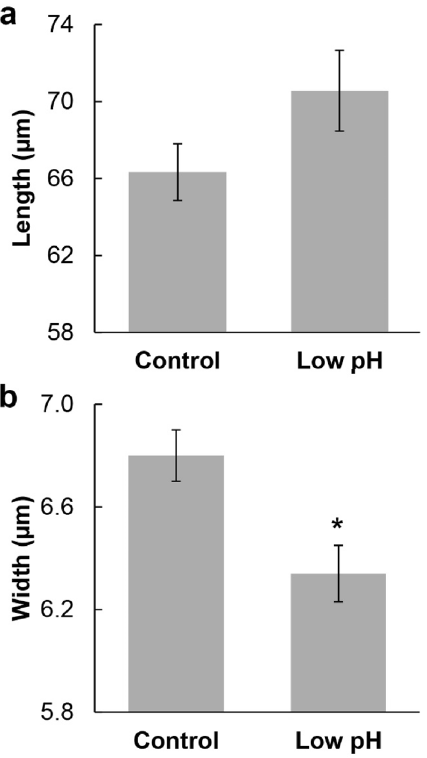
Figure 3. Mean measurements of the unpaired actines of the spicules synthesized during the ocean acidification experiment. ( a ) Length (N = 88 measurements per treatment); and ( b ) Width (N = 110 measurements per treatment). (*) thinner spicules under low-pH treatment ( p = 0.002). Error bars represent the standard